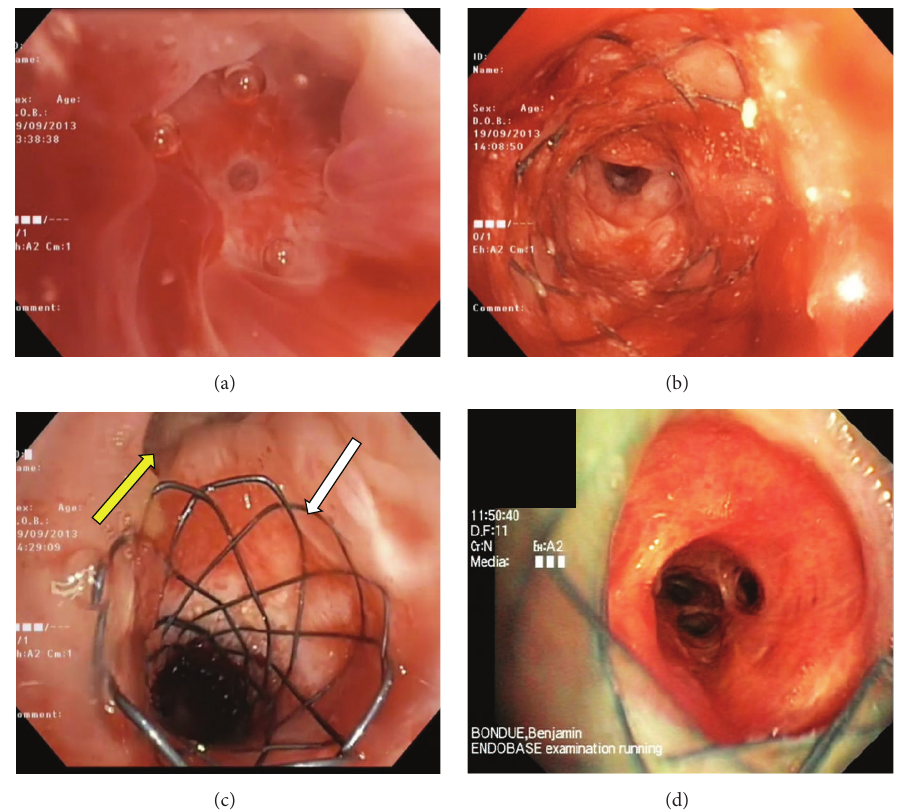
Figure1:(a)Endoscopicviewofthenear-completeposttransplantrestenosisoftherightbronchusintermedius.Asmallresidualorificeallows a recanalization by forceps first and then balloon dilation and argon plasma therapy. (b) Endoscopic view of the previously inserted metallic stent in the right bronchus intermedius below the proximal stenosis. The distal end is patent but anchored in a highly inflammatory tissue. (c) View of the proximal end of the newly inserted stent using the stent-in-stent technique. Note the spherical end with a higher diameter (10mm instead of 8 mm, white arrow) and the patent right upper bronchus (yellow arrow). (d) Endoscopic view of the distal end of the prosthesis 1 month later. The right lower lobe is ventilated and inflammation is